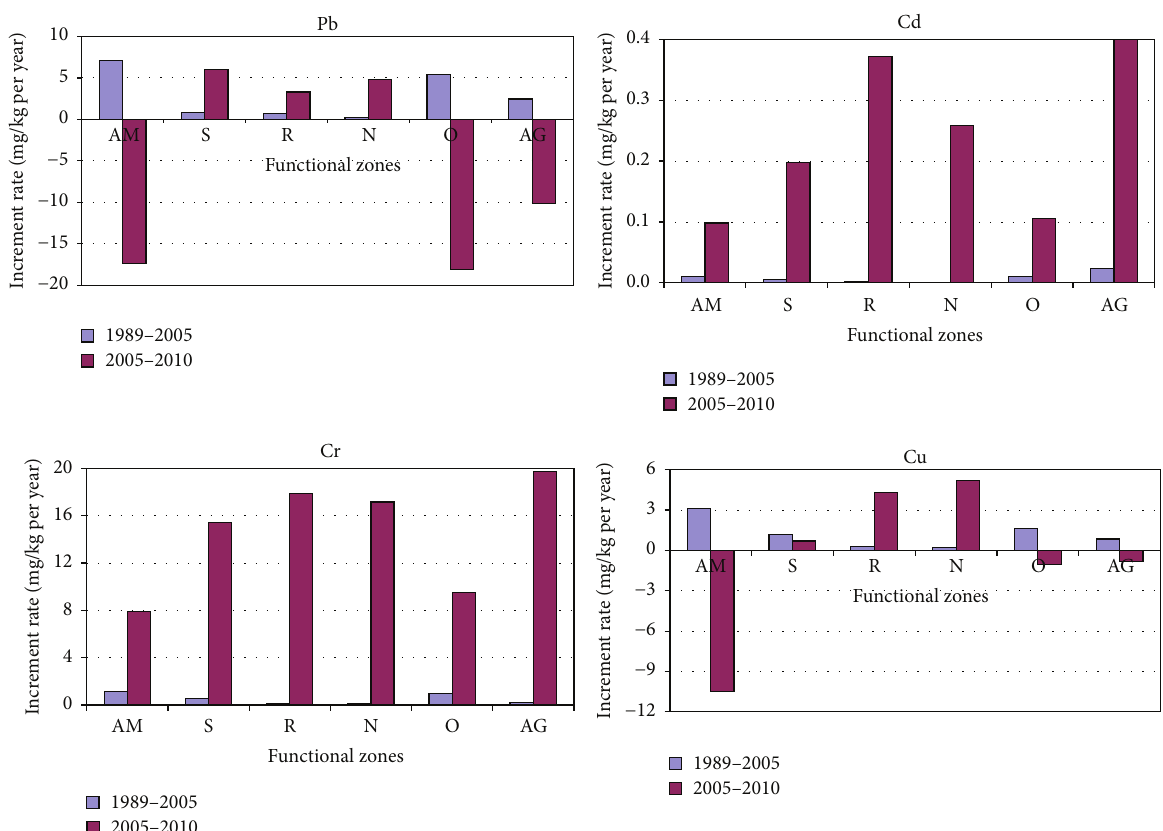
Figure 4: Average increase or reduction of the content of Pb, Cd, Zn, and Cr in the topsoils of different land-use zones in the Eastern district of Moscow for two periods of observations (1989–2005 and 2005–2010). Symbols of land-use zones are given in Table 2.